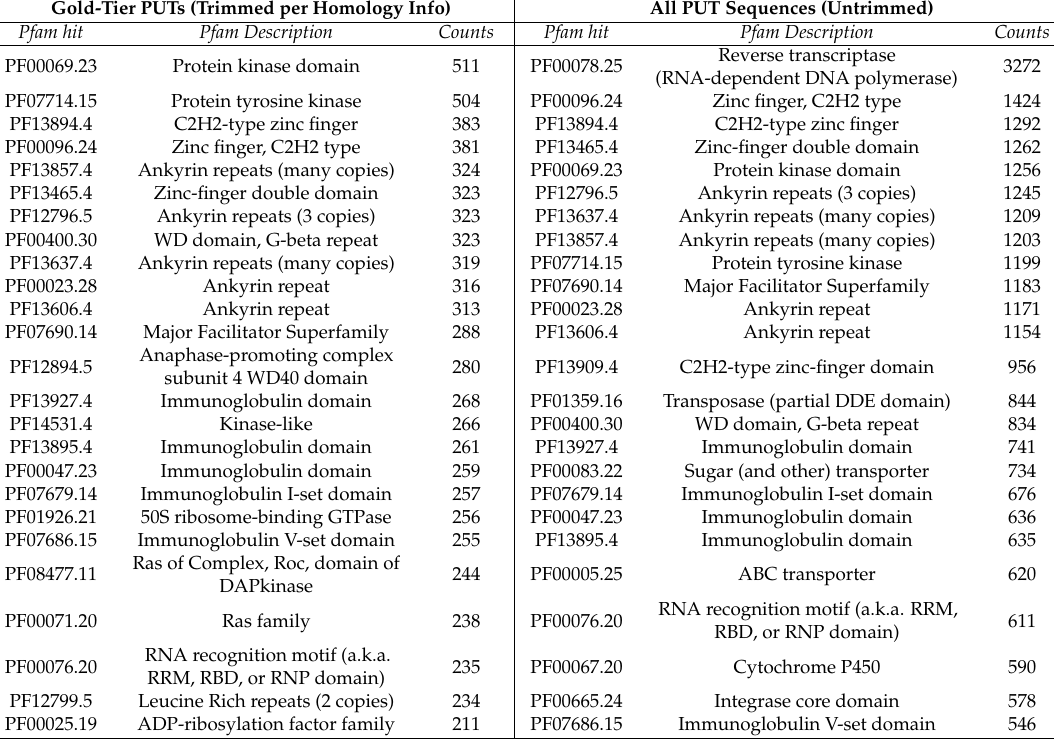
Table 2. The 25 most abundant Pfam families encountered in each of the gold-tier and complete harlequin bug PUT